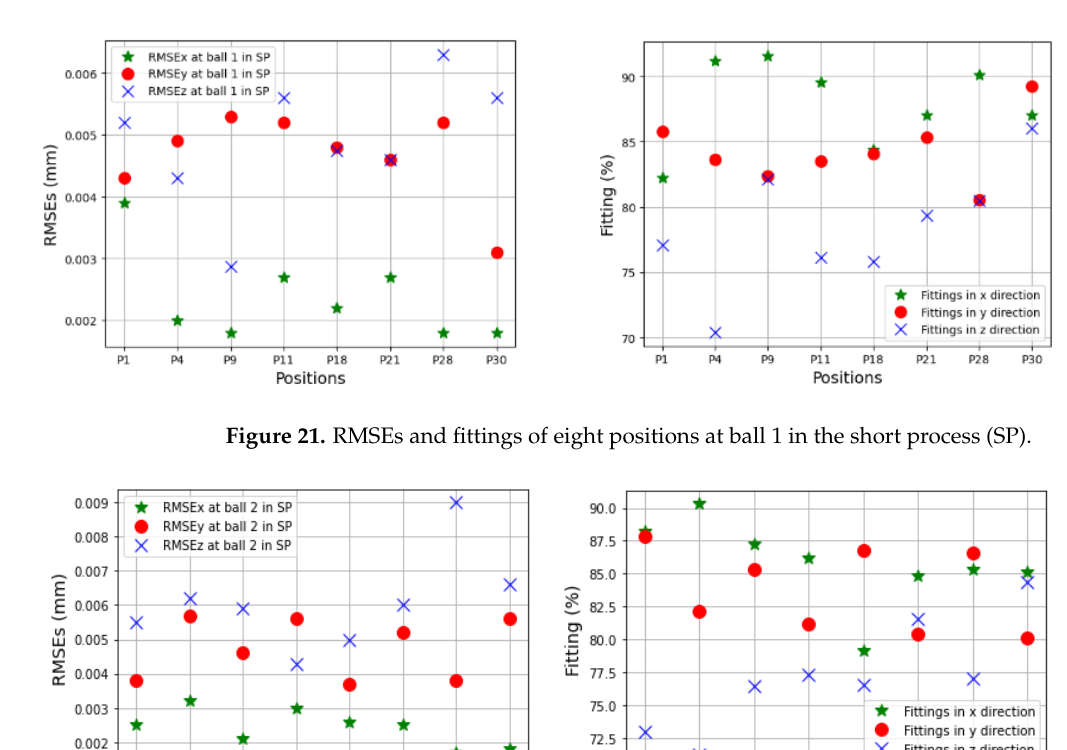
11 of 16 Figure 19. Prediction of TVEy25 and TVEz25 in the short process (SP) (1 cycle = 15 min). The Root Mean Square Errors (RMSEs) and fi tt ings of predictions compared with measured values are calculated by Equations (6) and (7) and are shown from Figures 20– 24.